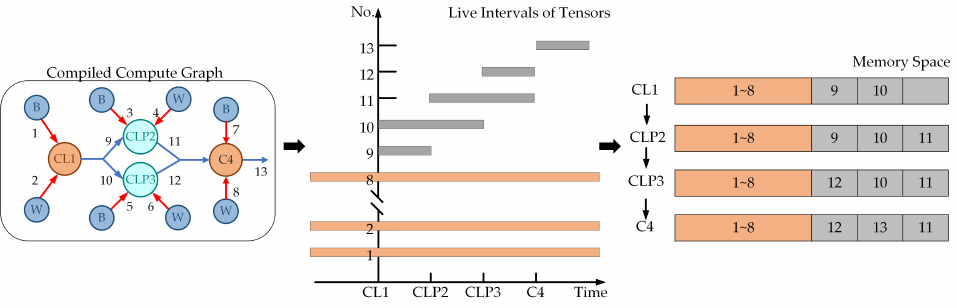
Figure 15. The processing flow of the memory allocator.